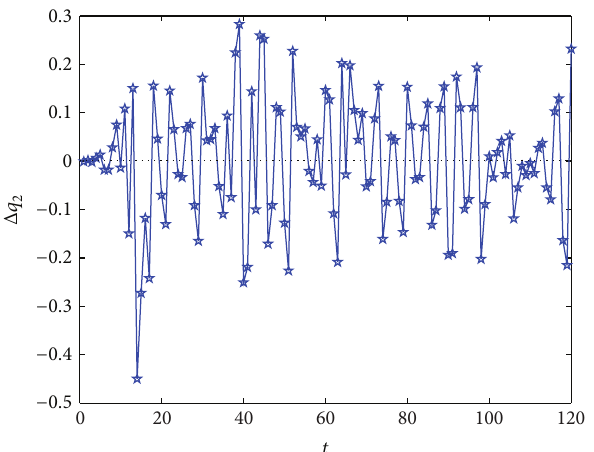
Figure 21: For 𝛼 1 = 1.32 , 𝛼 2 = 2.471 and 𝜃 = 0.5 , and the initial conditions which are (0.76, 0.92) and (0.76, 0.921), the difference with the change of time about the output 𝑞 2 .